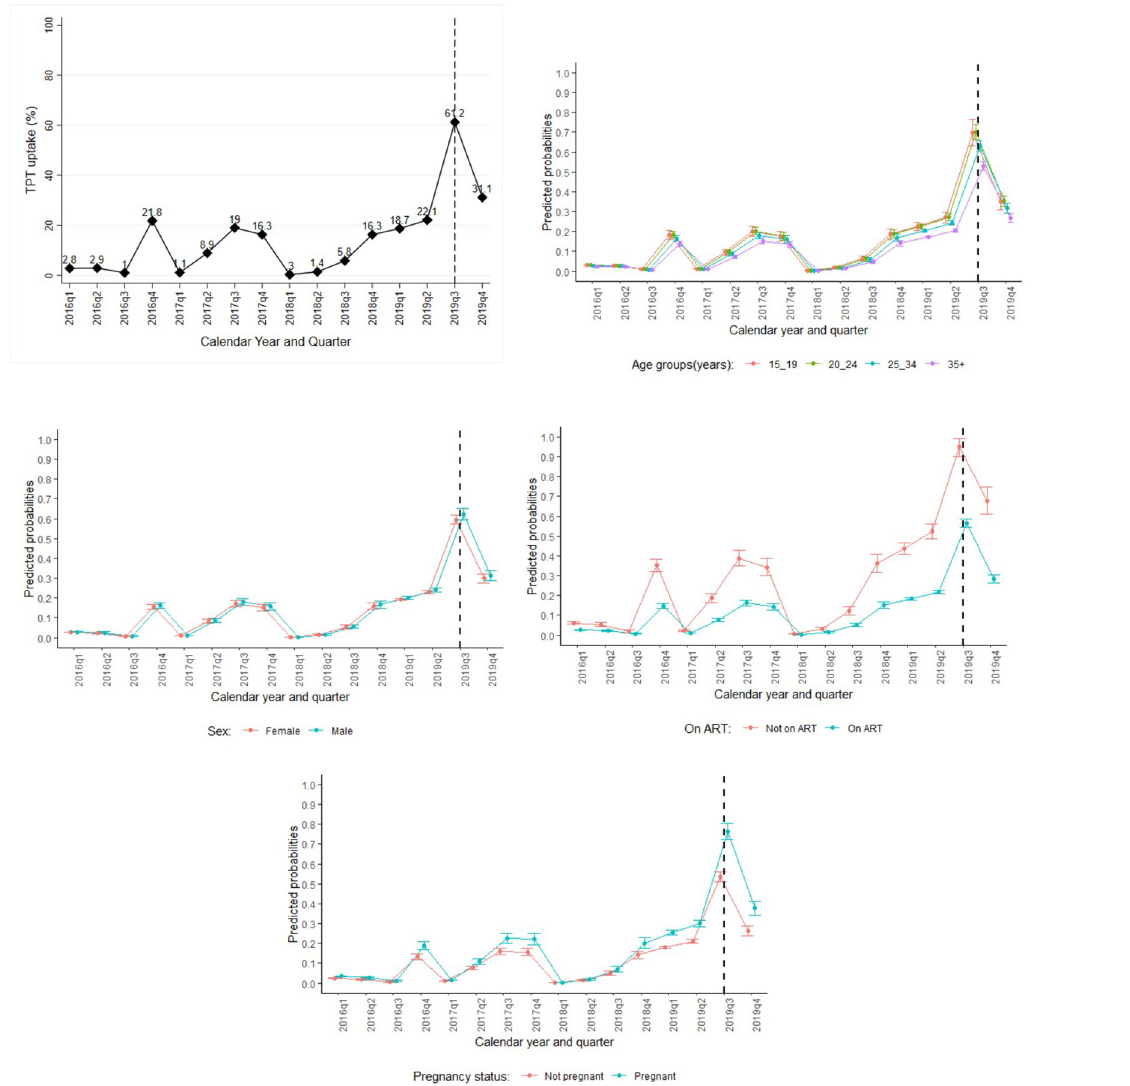
Fig 2. a: Trend of TPT uptake across calendar years and quarters. q1, q2, q3, and q4 denote quarters 1,2,3, and 4 respectively. The vertical black dashed line at 2019q3 indicates a point when the 100-day TPT accelerated campaign was rolled-out. b: Trend of predicted probabilities of TPT uptake by age groups. q1, q2, q3, and q4 denote quarters 1,2,3, and 4 respectively. The vertical black dashed line at 2019q3 indicates a point when the 100-day TPT accelerated campaign was rolled-out. Points on line graph represent predicted probabilities of TPT uptake from GEE modified Poisson regression model with cluster standard errors to account for correlation of outcomes within each of the 6 clinics, adjusting for sex, age groups, ART status, WHO stage. Model was fitted with interaction between quarter of calendar year and age groups covariates. c: Trend of predicted probabilities of TPT uptake by sex. q1, q2, q3, and q4 denote quarters 1,2,3, and 4 respectively. The vertical black dashed line at 2019q3 indicates a point when the 100-day TPT accelerated campaign was rolled-out. Points on line graph represent predicted probabilities of TPT uptake from modified Poisson GEE regression model with cluster standard errors to account for correlation of outcomes within each of the 6 clinics, adjusting for sex, age groups, ART status, WHO stage. Model was fitted with interaction between quarter of calendar year and sex covariates. d: Trend of predicted probabilities of TPT uptake by ART status. q1, q2, q3, and q4 denote quarters 1,2,3, and 4 respectively. The vertical black dotted at 2019q3 line indicates a point when the 100-day TPT accelerated campaign was rolled-out. Points on line graph represent predicted probabilities of TPT uptake from modified Poisson GEE regression model with cluster standard errors to account for correlation of outcomes within each of the 6 clinics, adjusting for sex, age groups, ART status, WHO stage. Model was fitted with interaction between quarter of calendar year and sex covariates. e: Trend of predicted probabilities of TPT uptake by pregnancy status. q1, q2, q3, and q4 denote quarters 1,2,3, and 4 respectively. The vertical black dotted at 2019q3 line indicates a point when the 100-day TPT accelerated campaign was rolled-out. Points on line graph represent predicted probabilities of TPT uptake from modified Poisson GEE regression model with cluster standard errors to account for correlation of outcomes within each of the 6 clinics, adjusting for sex, age groups, ART status, WHO stage. Model was fitted with interaction between quarter of calendar year and sex covariates.